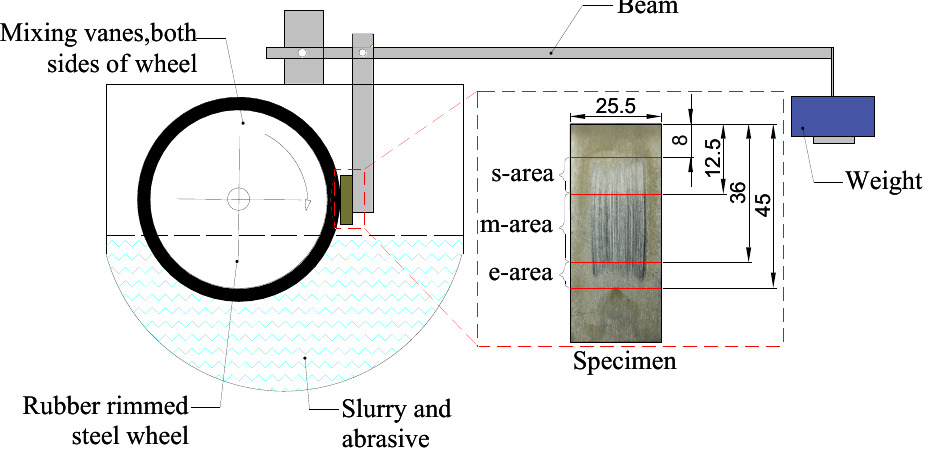
Figure 1. The schematic diagram of the modified ASTM B611 test system.